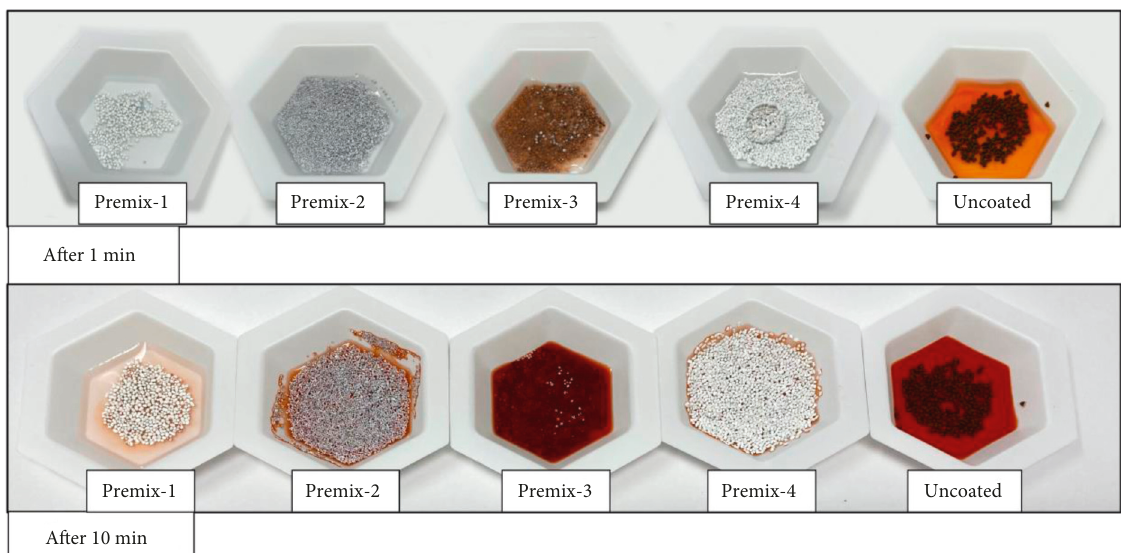
Figure 8: Qualitative iron test after 1 and 10 minutes of addition of phenanthroline colour reagent on Indian premixes 1–3, UofTpositive control 4, and uncoated extruded ferrous fumarate. The intense red-orange colour formation of Premix-3 indicates the poor quality of the coating.